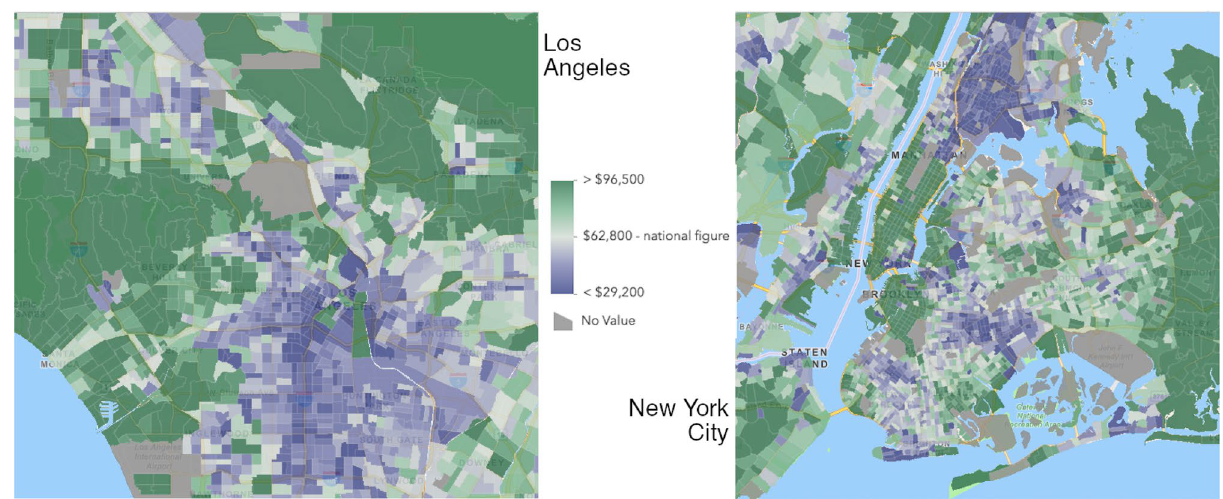
Figure 5. Median household income by tract in LA (Left) and NYC (Right). The income data is from American Community Survey 2019, and the maps are produced by ArcGIS Online (www. arcgis.